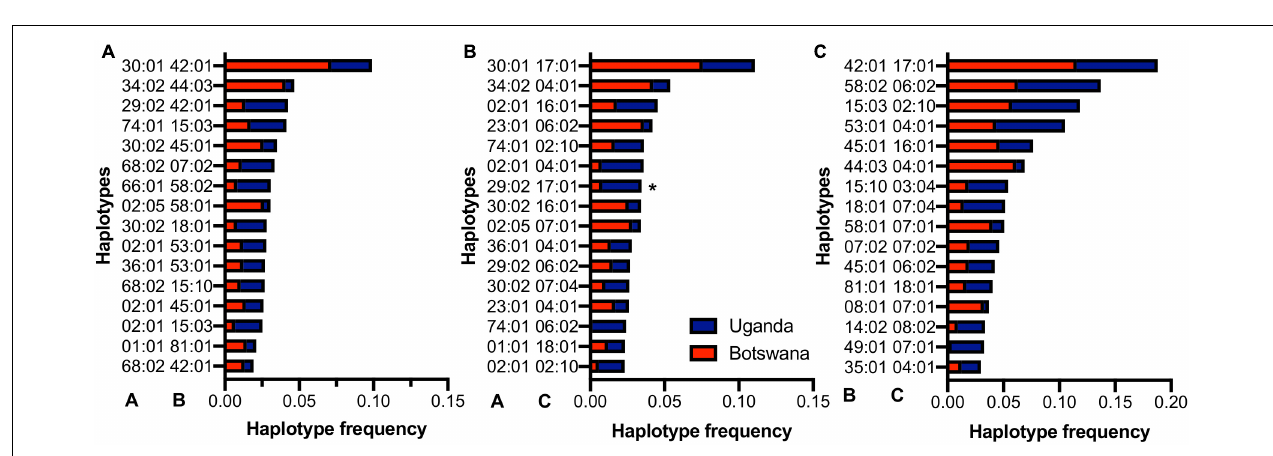
FIGURE 2 | Patterns of linkage disequilibrium (LD) between the most frequent class I HLA alleles. LD in our cohort is expressed as the R 2 values. LD plots were produced with (A) 56 alleles in the combined cohort, (B) 59 alleles in Uganda, and (C) 56 alleles in Botswana with a frequency ≥ 1%. The colors indicate increasing strength of LD from yellow to red. Alleles on the same HLA locus (no pairwise LD comparisons) are indicated in gray. Alleles associated with LTNP in the cohort are highlighted in red.